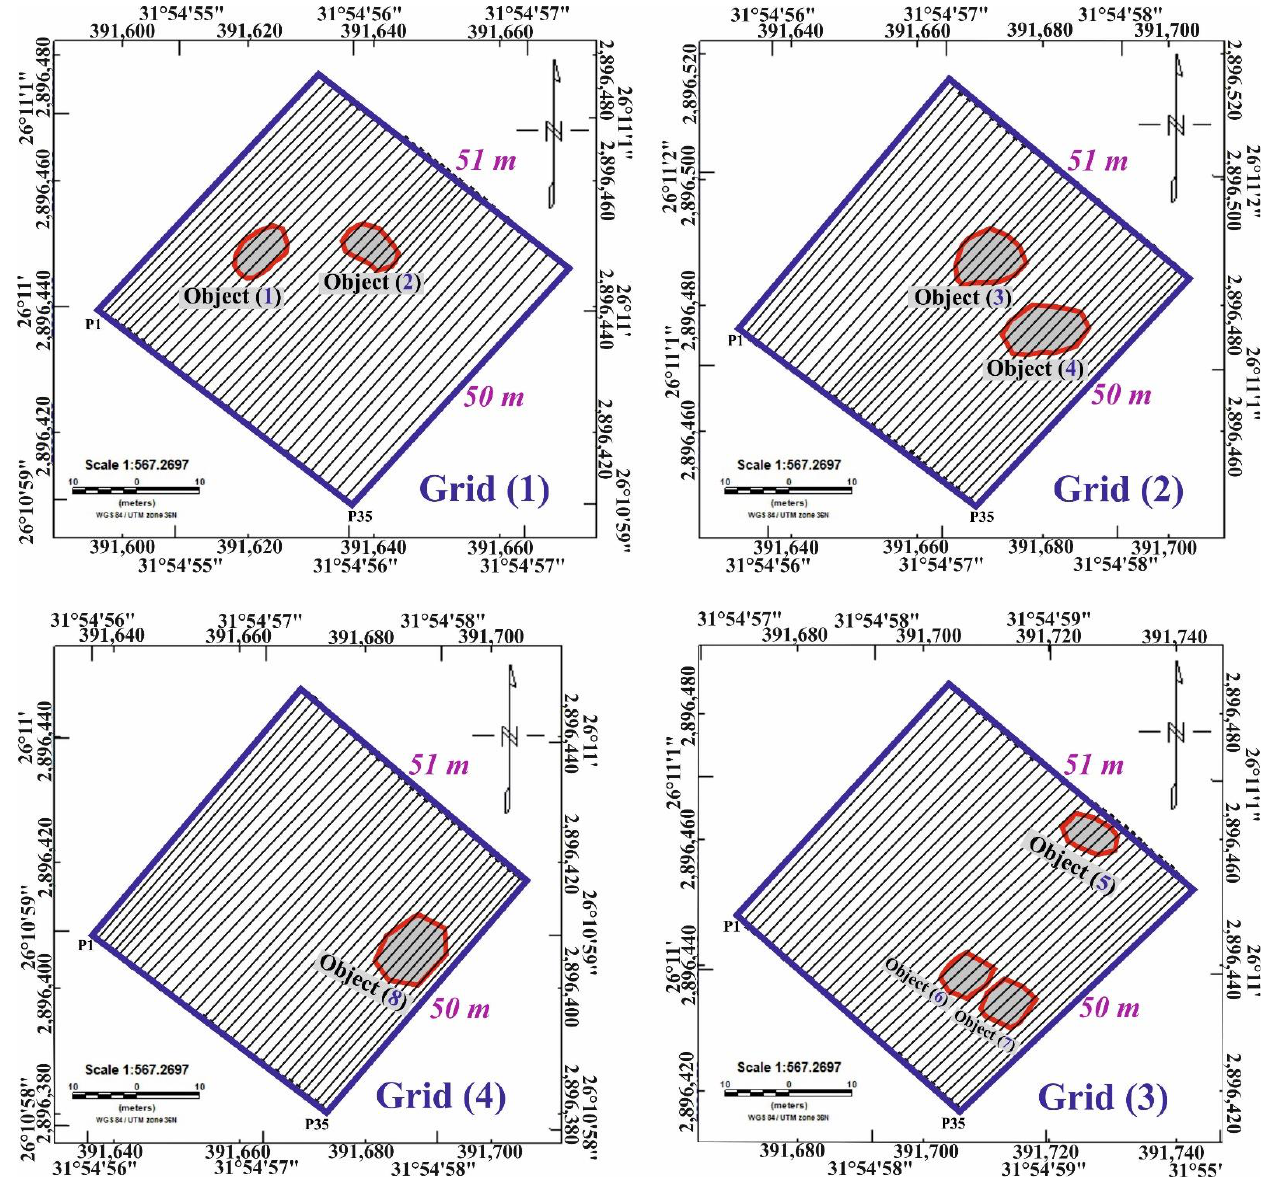
Figure 11. Locations of the potential archaeological targets, inferred from magnetic and GPR results. They were represented by red circles.